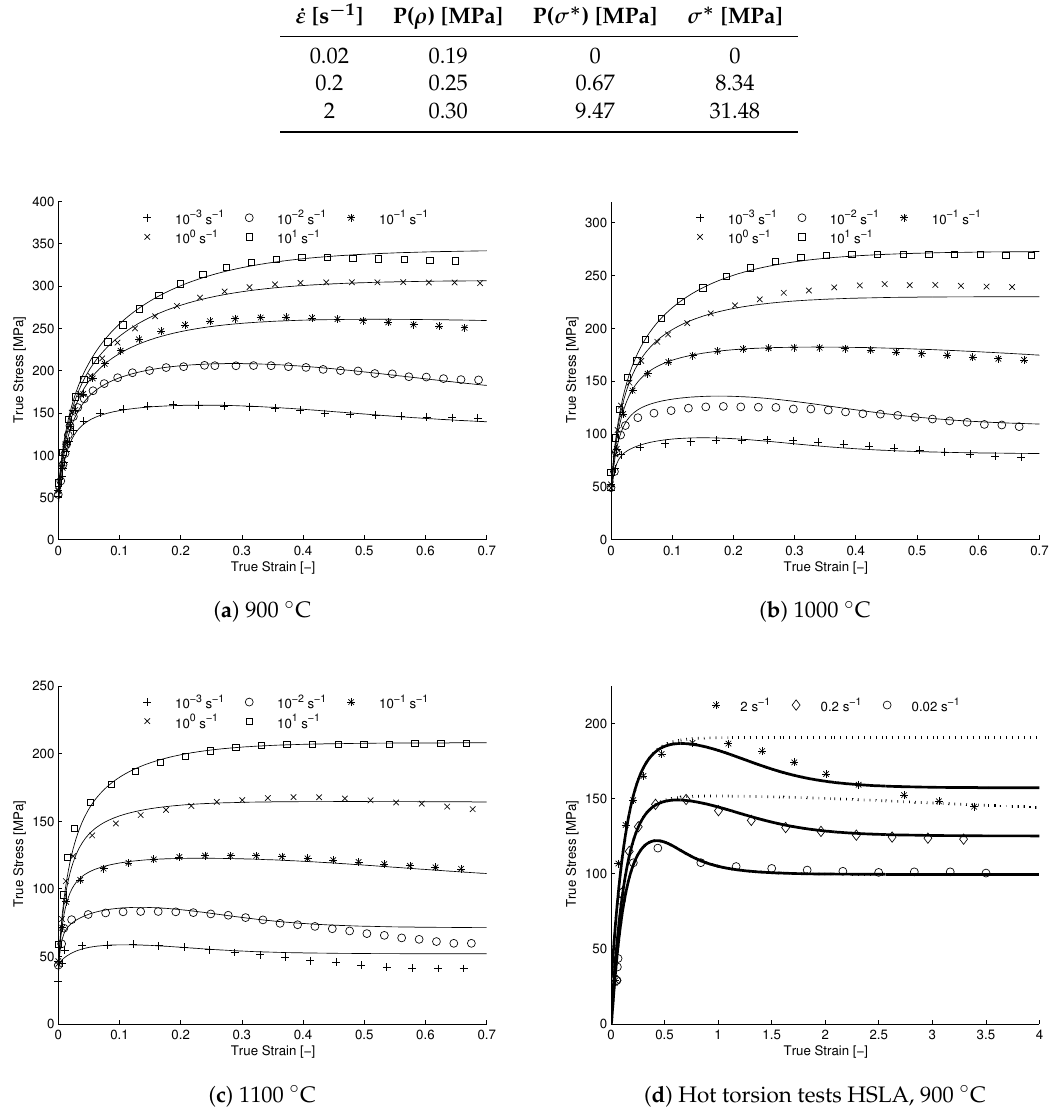
Figure 3. ( a – c ) Model validation for AISI 316LN for strain rates ranging from 10 − 3 s − 1 –10 1 s − 1 and temperatures ranging from 900 ◦ C–1100 ◦ C, model results shown in solid line. ( d ) Model validation for HSLA-steel for strain rates ranging from 0.02 s − 1 –2 s − 1 and a temperature of 900 ◦